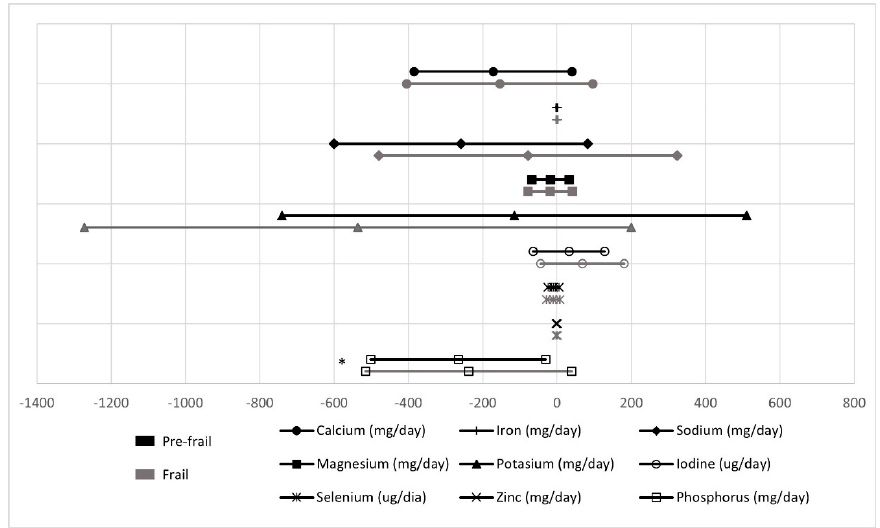
Figure 4. Mineral intake in pre-frail and frail groups compared with robust (reference group). * Statistically significant differences ( p value < 0.05).